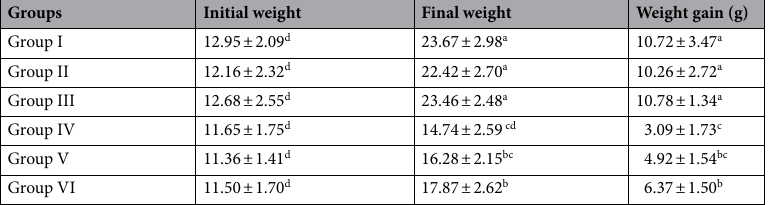
Table 3. Effect of pendimethalin and curcumin on weight gain. Group I: tap water (control), Group II: 5 mg/L curcumin, Group III: 10 mg/L curcumin, Group IV: 12 mg/L pendimethalin, Group V: 12 mg/L pendimethalin + 5 mg/L curcumin, Group VI: 12 mg/L pendimethalin + 10 mg/L curcumin. Data are shown as mean ± standard deviation (SD). The averages shown with different letters in the same column are